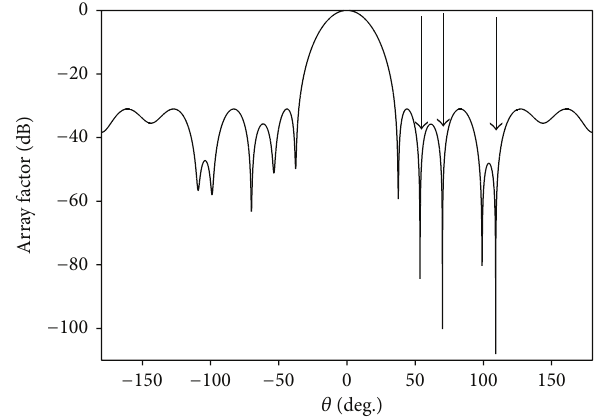
Figure 20: Radiation pattern obtained by amplitude-only control with triple imposed null at 53 ∘ , 70 ∘ , and 109 ∘ .